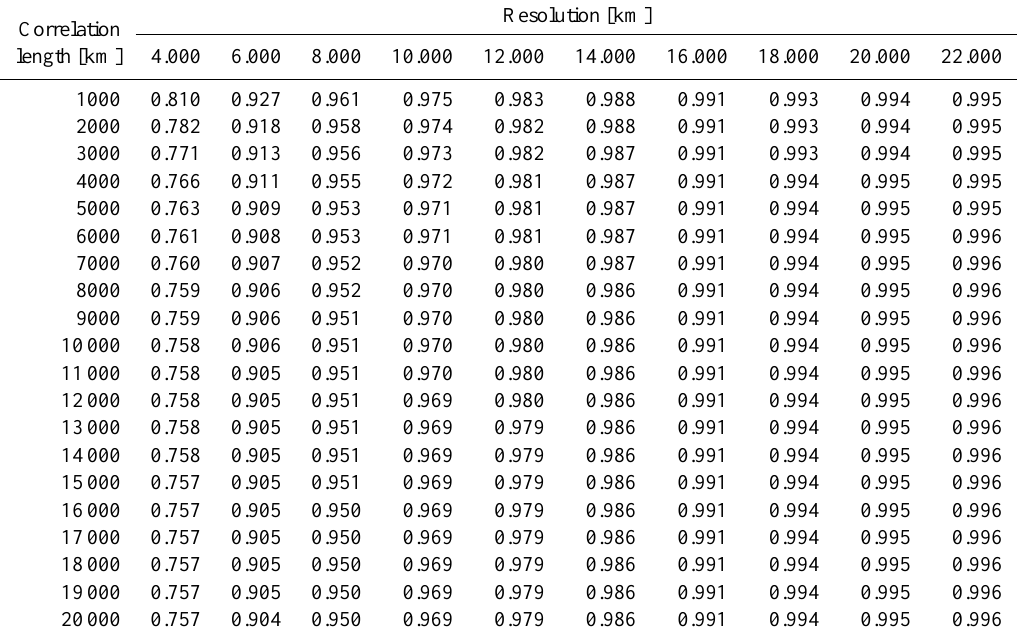
Table 2. Ratio of correctly calculated smoothing errors and smoothing errors calculated using interpolated averaging kernels.